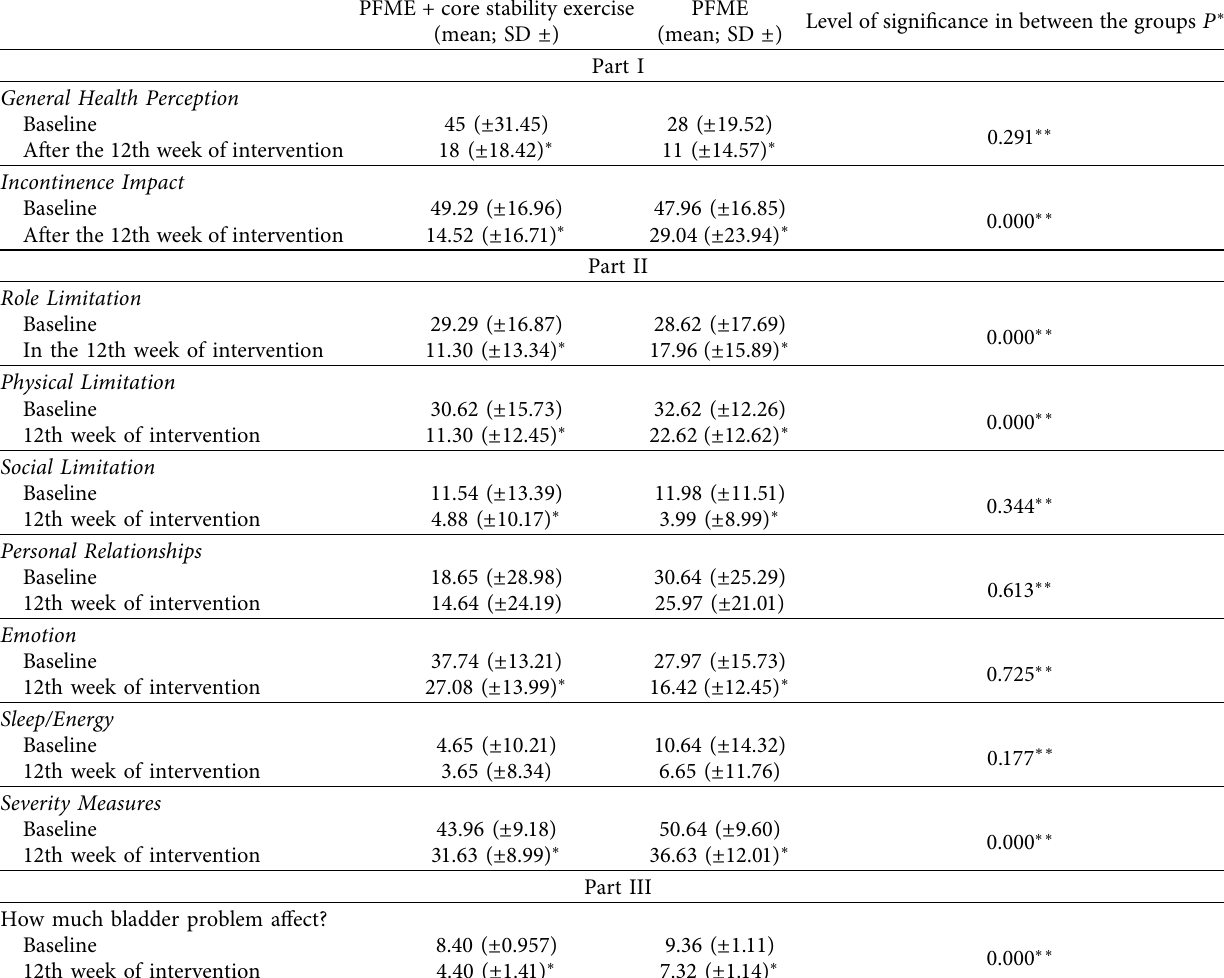
Table 5: Secondary outcome of the intervention of both